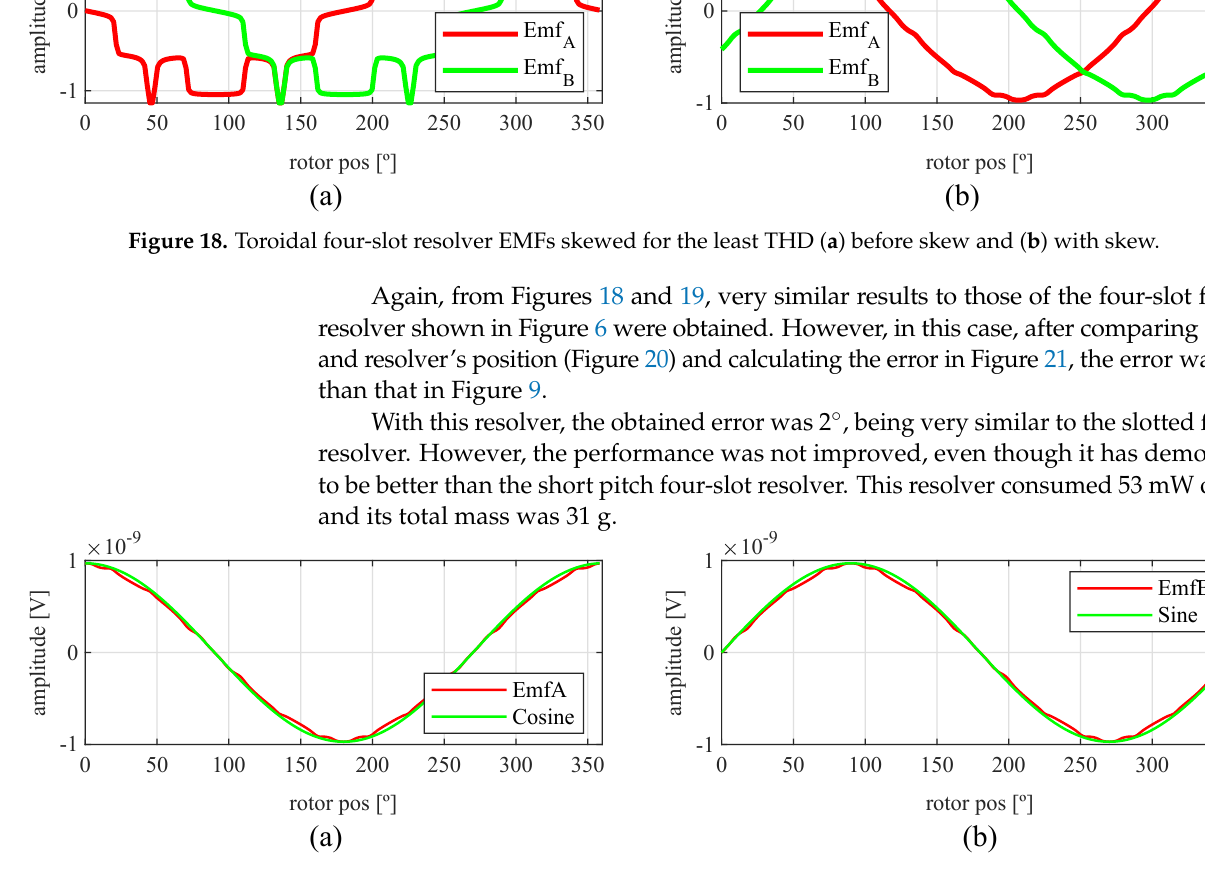
Figure 19. Toroidal four-slot skewed resolver EMFs vs. ideal signals ( a ) EMF A vs. Cosine and ( b ) EMF B vs.